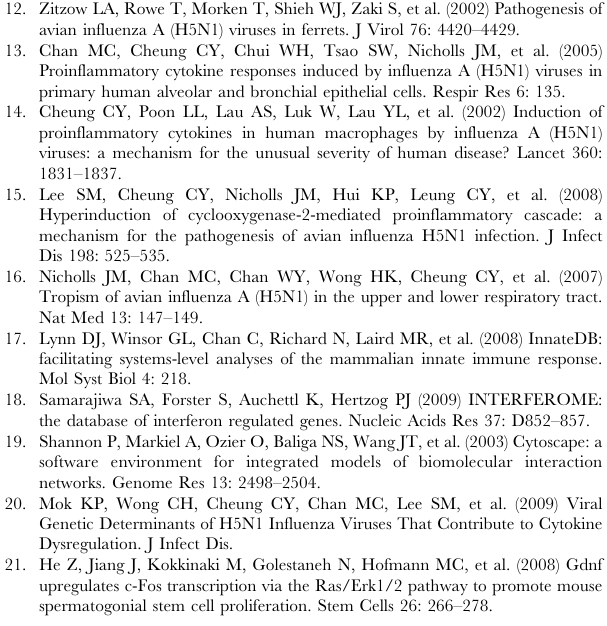
Table S1 Summary of gene expression in response to influenza A virus infection. Fold change of gene expression in response to H1N1 and H5N1 compared to mock infection at 1, 3 and 6 h post-infection time were shown. The ‘‘-’’ and no sign before the number indicates the down- and up-regulation of the gene respectively in influenza A infected cells compared to